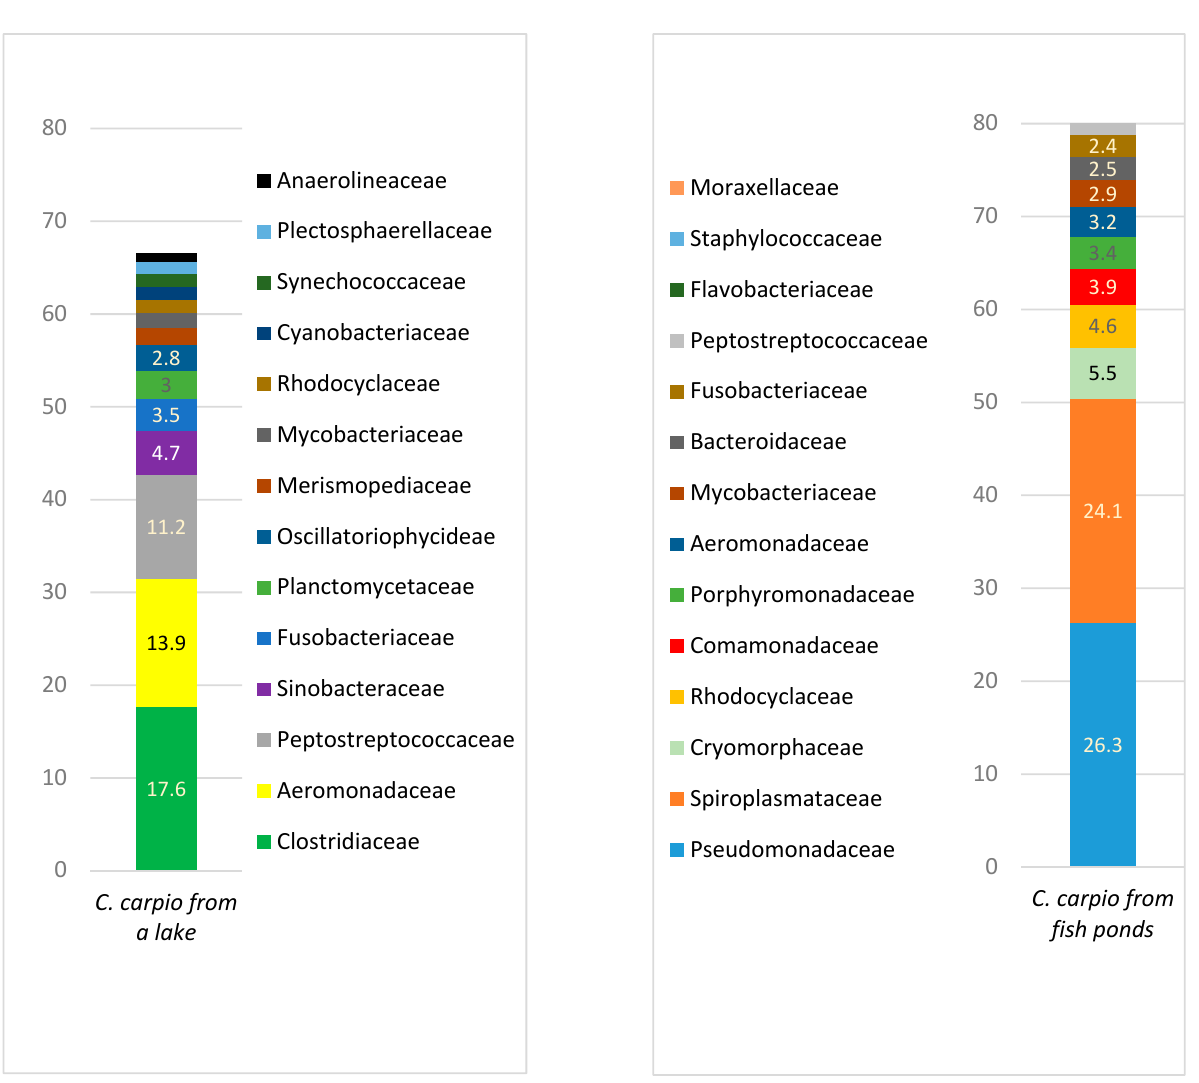
Figure 3. Bacterial family prevalence (%) in C. carpio gut (prevalence of at least ≥ 1%). Figure 3 represents microbial profiles from carp gut on a family level. Although the amount of different families with a prevalence above 1% from the total count of bacteria in both groups was similar and contained 14 different families, their taxonomical composition was different. The most prevalent bacterial families in carp from fish ponds were Pseudomonodaceae, Spiroplasmataceae, and Cryomorphaceae, while in the lake carp Clostridiaceae, Aeromonadaceae, and Peptostreptococcaceae predominated. The overall bacterial variety was much higher in lake carp (including those with a prevalence less than 1%) if all the bacterial families detected were counted (Tables S1 and S2). Families which are treated as pathogens or opportunistic pathogens, such as Moraxellaceae, Flavobacteriaceae, and Staphylococcaceae, were detected only in the gut of carp from the fish pond. Figure 4 represents the bacterial variety in the gut of carp from fish ponds and the lake. The most prevalent genera in carp from fish ponds were Pseudomonas , Spiroplasma , Owen- weeksia, and Paludibacter, while in the lake carp the predominant genera were Clostridium , Aeromonas , Romboutsia, and Cetobacterium . The variety of genera was significantly higher in the gut of lake carp, where 310 genera were identified with a prevalence of ≥ 0.01%, compared to 118 genera in the pond fish (Tables S3 and